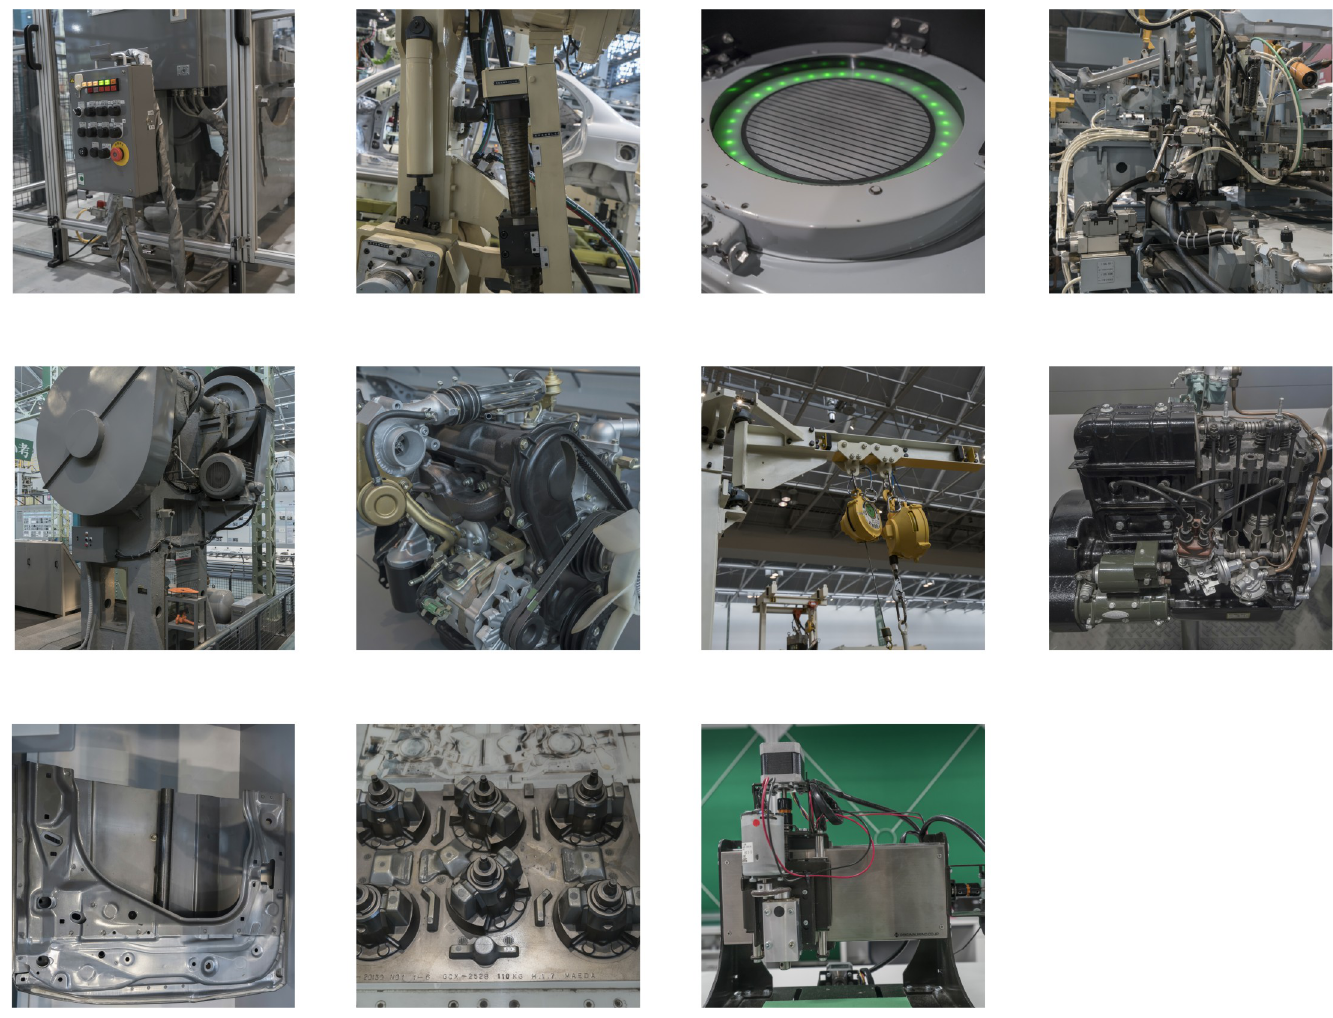
Fig 3. Examples of dataset